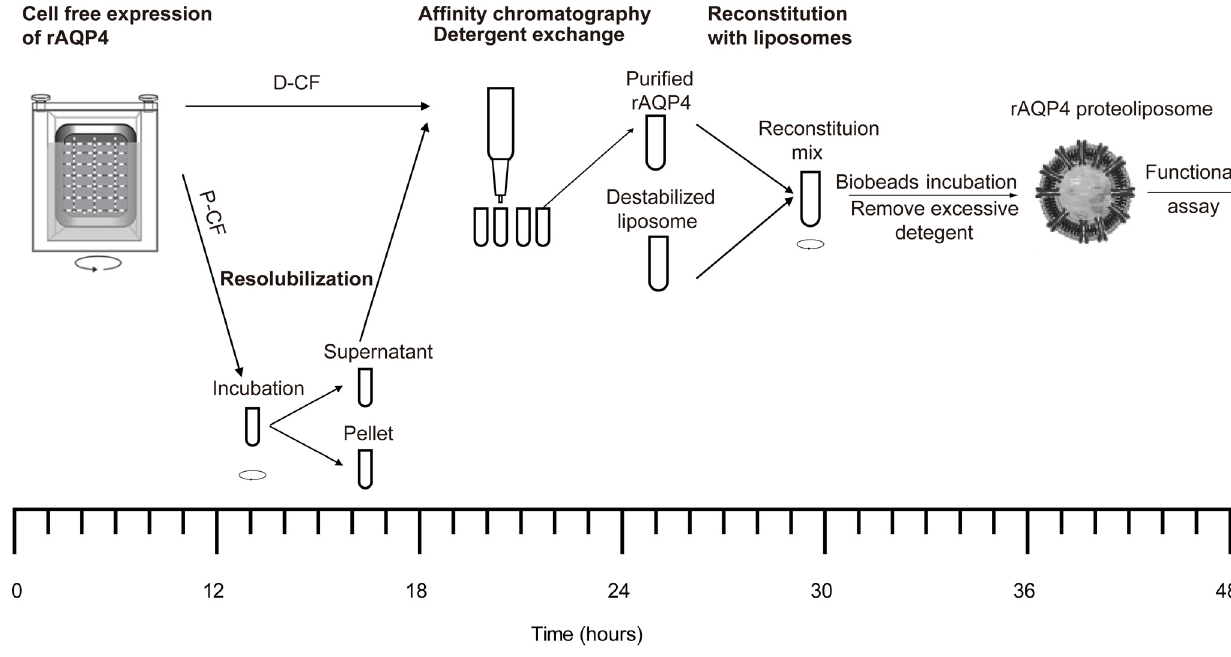
Figure 6. Flow-chart of mAQP4 M23 production by CF expression. The complete process from expression to functional analysis is finished within 2 days.